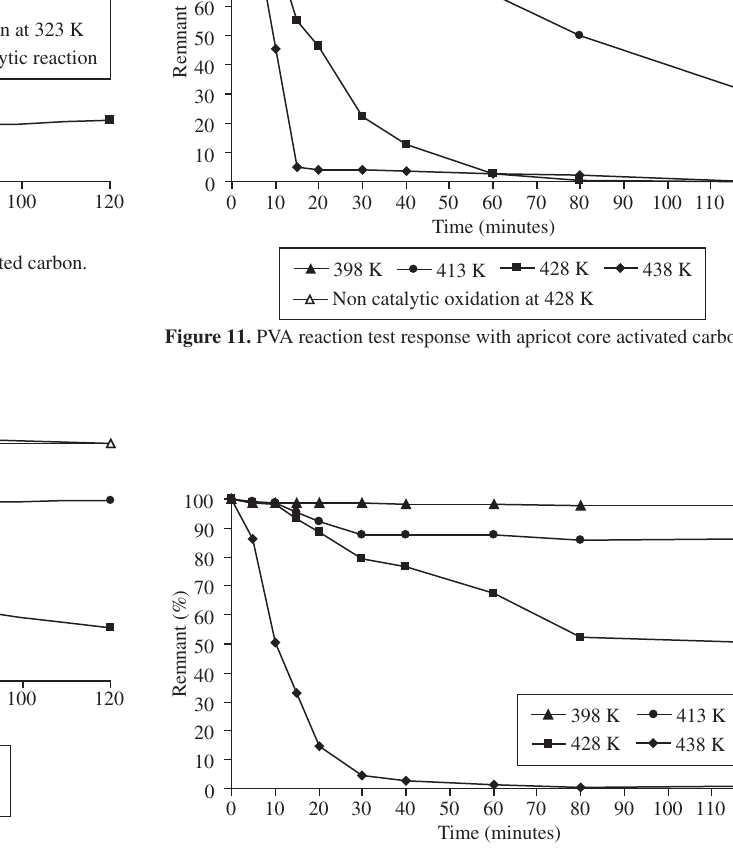
Figure 12. PVA reaction test response with grape stalk activated carbon.